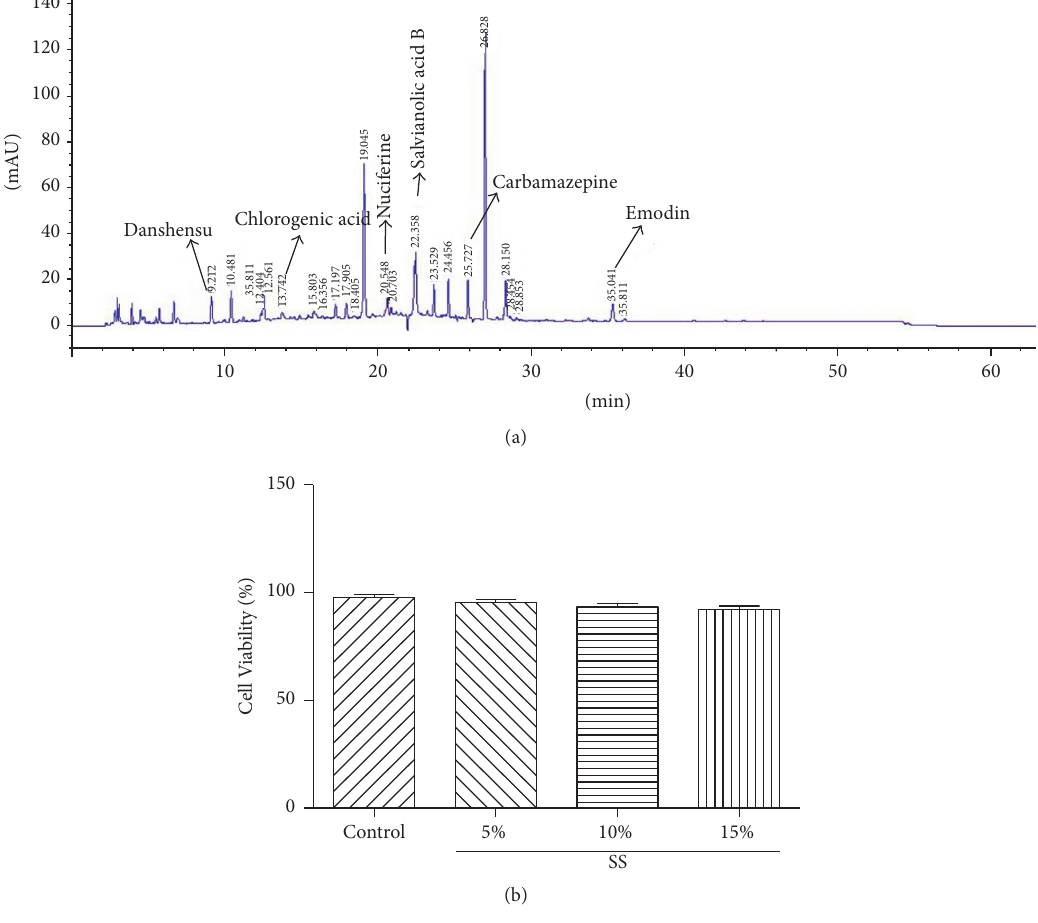
Figure 2: The properties of SNN-containing serum. Qualification of the main ingredients with HPLC (a). Different concentrations of SNN- containing serum (5%, 10%, 15%) on Kupffer cell viability (b). SS: SNN-containing serum. (b) is originated from GraphPad Prism 5.01, and data is